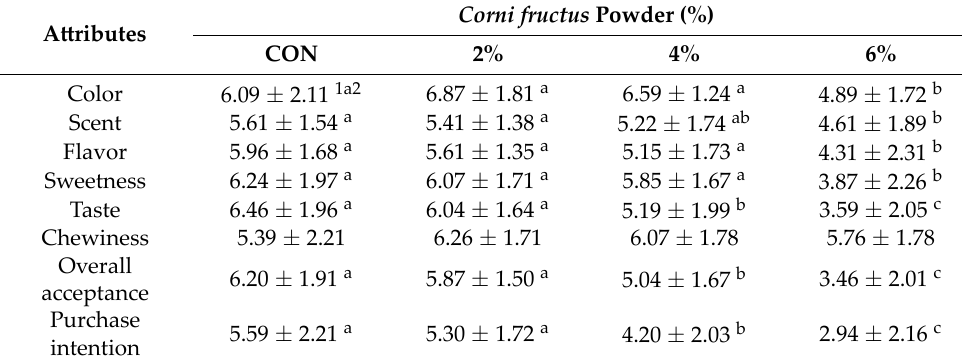
Table 7. Consumers’ preferences for Yanggaeng treated with Corni fructus